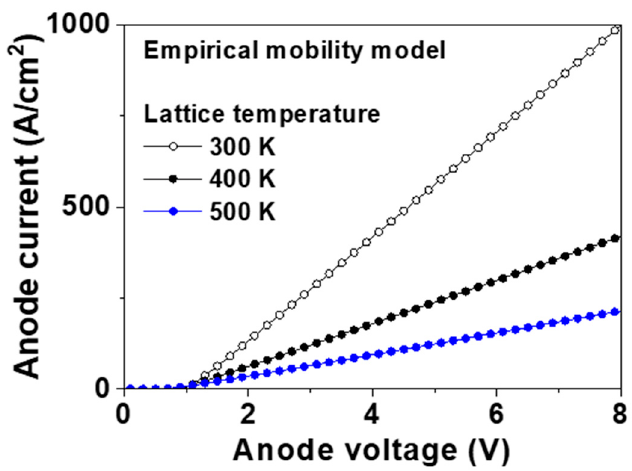
Figure 8. Forward current–voltage (I–V) of the p-type diamond pseudo-vertical Schottky barrier diode (SBD) simulated using the empirical mobility model at 300, 400, and 500 K. The metal work function, hole saturation velocity, hole mobility at 300 K, and β were 5.65 eV, 2.7 × 10 7 cm / s, 1990 cm 2 / Vs, and 3.092, respectively.